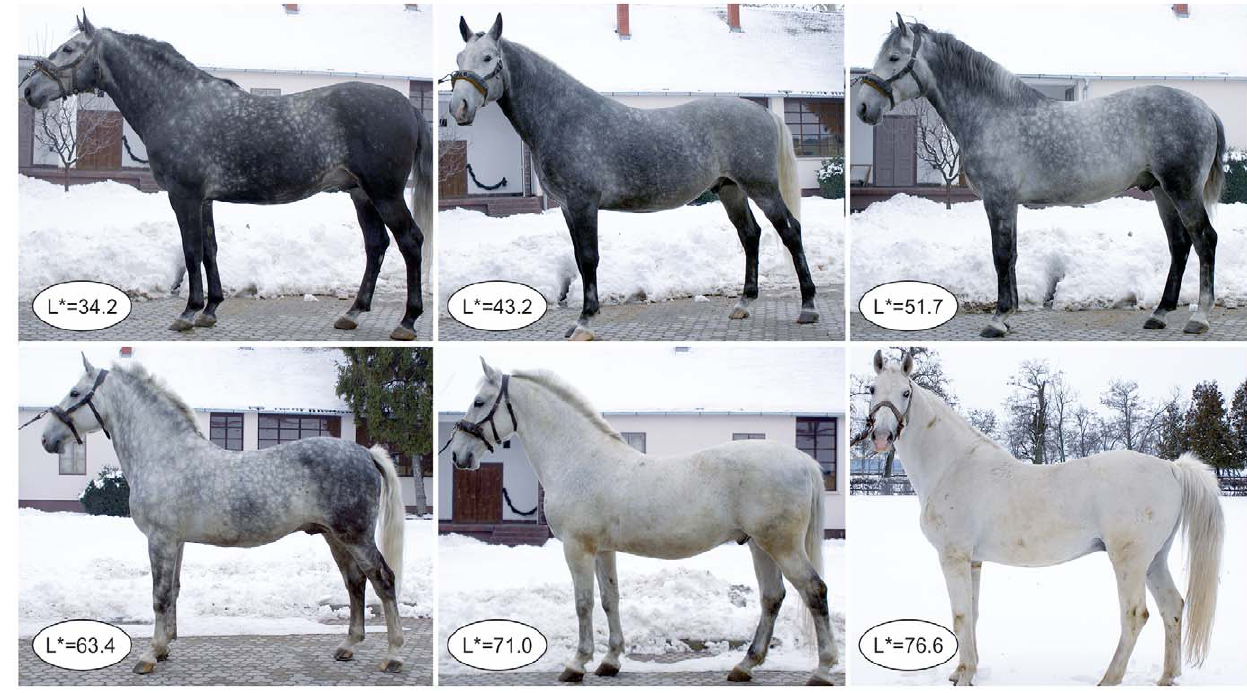
Figure 4. Variation of vitiligo grade in four grey Lipizzan horses.